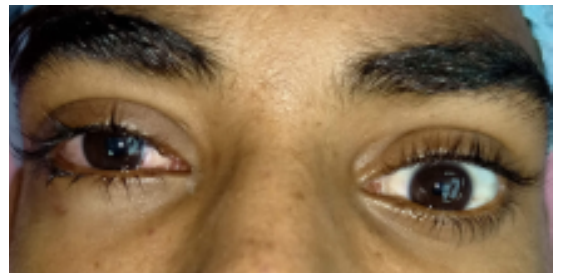
Figure 1: Superior displacement of the globe with no external scar